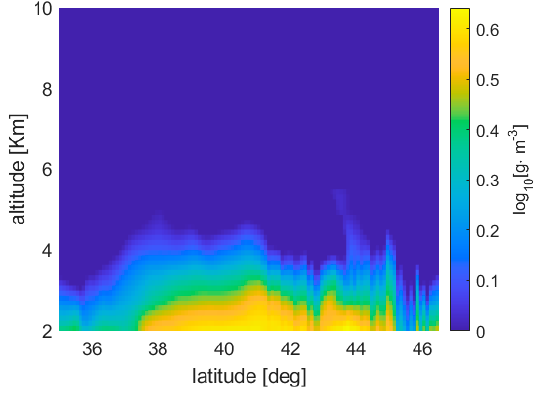
Figure 6. ( a ) True WV field (analysis of 24 July 2020 11:30am) as a function of angle and altitude; ( b ) retrieved WV field with ERTA and ( c ) the corresponding normalized error field; ( d ) retrieved WV field with LSATR and ( e ) the corresponding normalized error field defined as in Equation (17). Satellite configuration: 1Tx ‐ 10Rx.